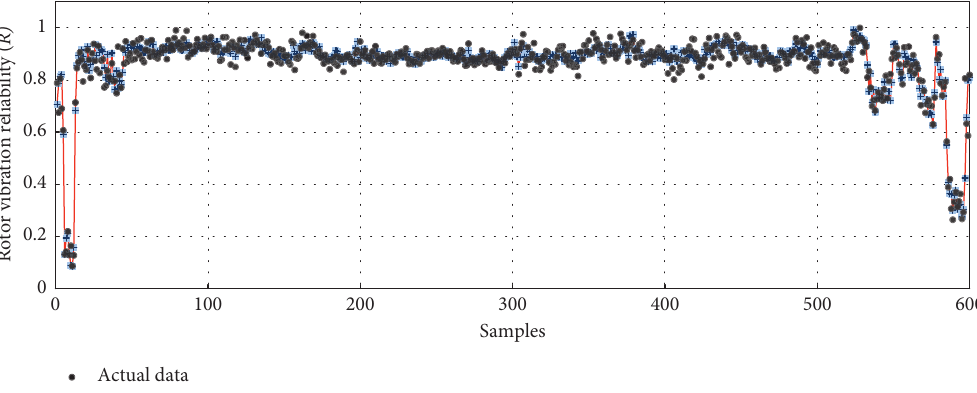
Figure 5: Regression prediction of R .